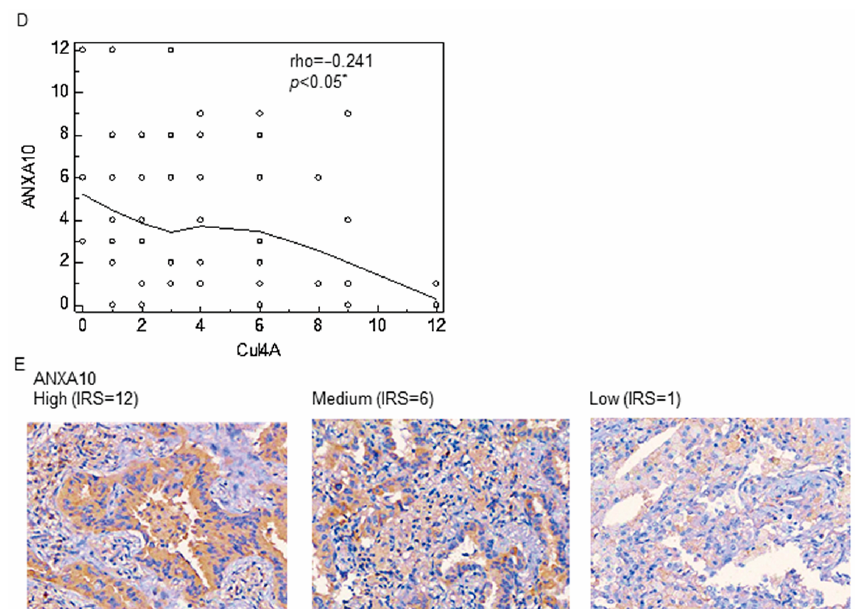
Figure 1. Cul4A is upregulated in non-small cell lung cancer (NSCLC). ( A ) Cul4A levels are determined by IHC staining in the NSCLC tumor and paired normal tissues. The expression of Cul4A is quantified by an IRS score, and the values are expressed as means (±SD). ( B ) Disease-free survival (DFS) of NSCLC patients after surgery is grouped based on a low (IRS ≤ 6) or high (IRS > 6) Cul4A expression. ( C ) Representative images for the expression of Cul4A in NSCLC tissues are shown. Original magnification, 200×. ( D ) Correlation of the expression of Cul4A and ANXA10 in the NSCLC tissues. ( E ) Representative images for the expression of ANXA10 in NSCLC tissues are shown. Original magnification, 200×. IRS: immunoreactive score.